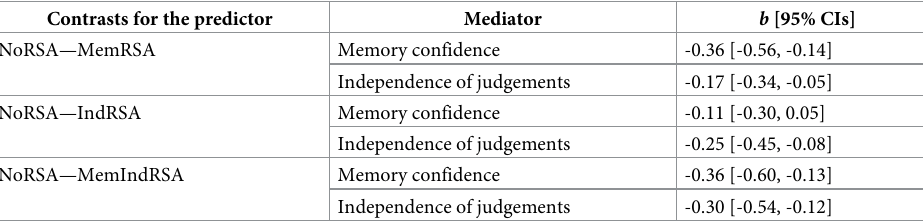
Table 4. Results of mediation analysis—Experiment